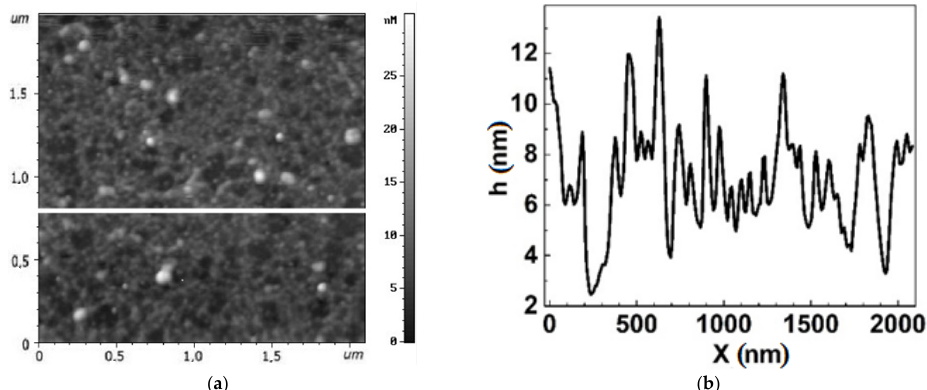
Figure 6. Topography of the graphene surface in chip EG392-1 from Group 2 after functionalization. ( a ) AFM image of the surface. ( b ) AFM profile of the graphene surface along the line in ( a ), showing the characteristic nanomaterial arrangement of the surface. Bright areas are equivalent to peaks with large magnitude on the profile curve.